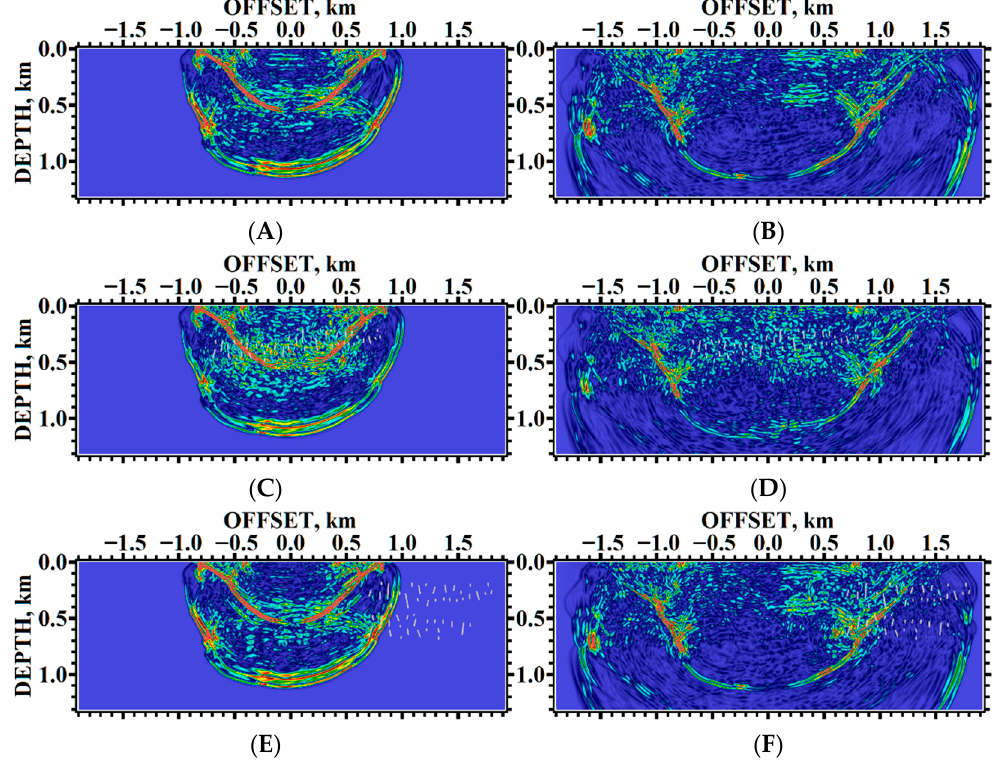
Figure 33. Example #5, velocity modulus snapshot: ( A , B ) «without fractures», time of 0.275 s ( A ) and time